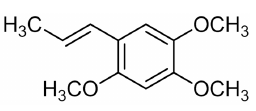
Figure 1. The structure of α -asarone.